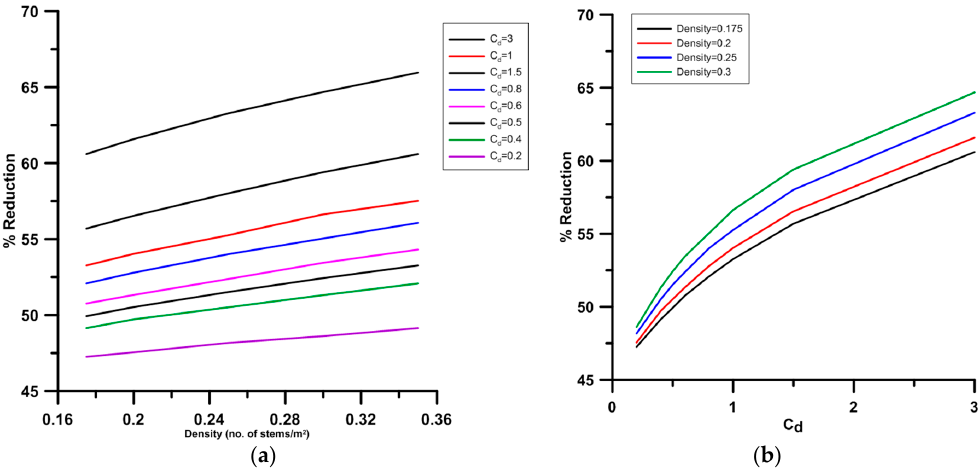
Figure 8. Wave height attenuation: ( a ) varying vegetation density and different C d , and ( b ) varying C d for different vegetation density.